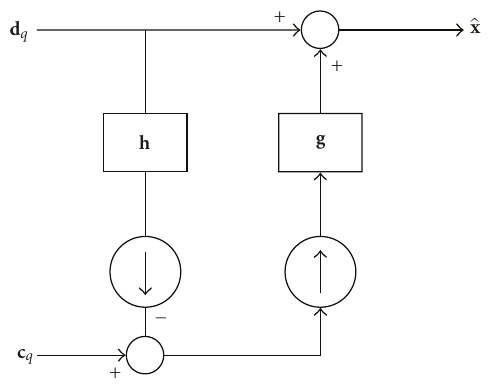
Figure 4: Frame-based reconstruction structure for